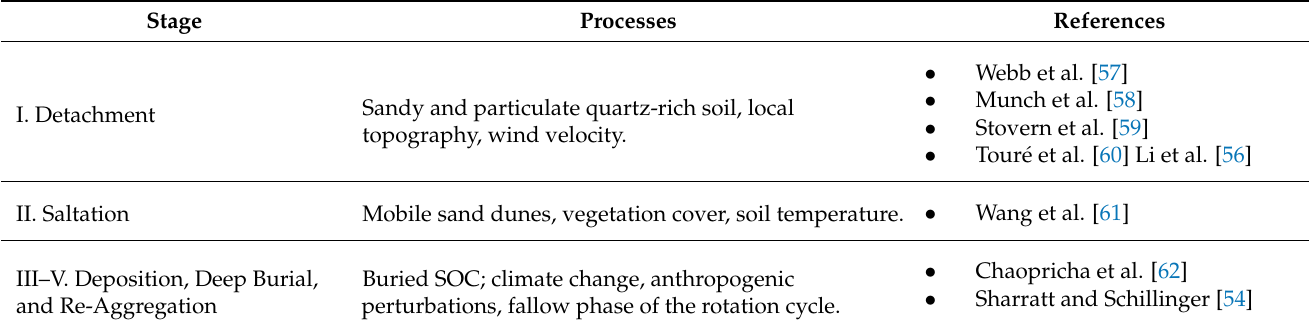
Table 2. Gaseous emissions at different stages of aeolian erosion